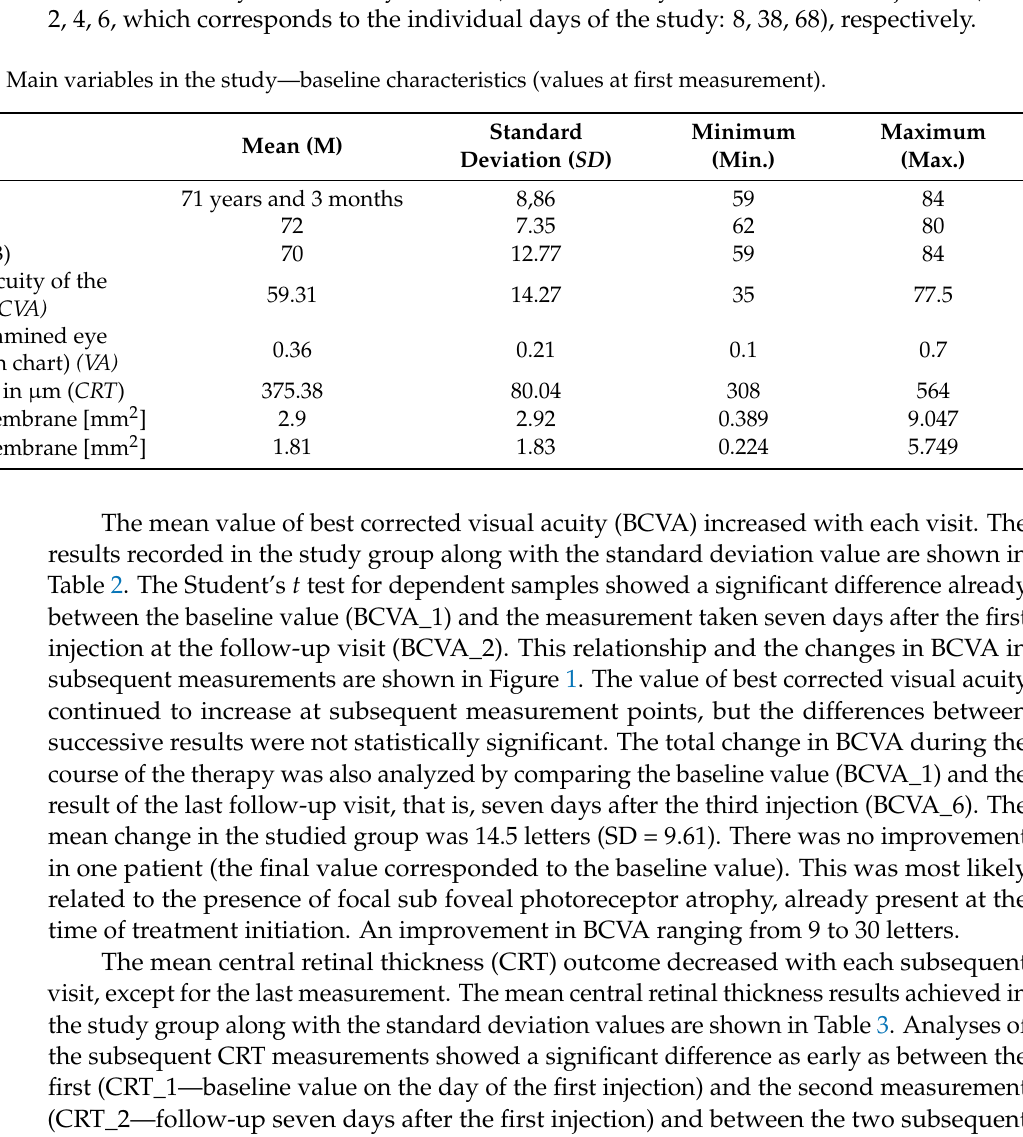
Table 1. Main variables in the study—baseline characteristics (values at first measurement).